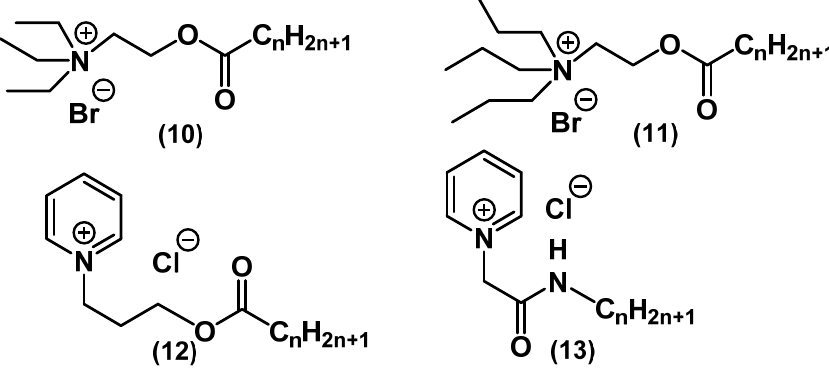
Figure 8. “Soft” mono-QACs.